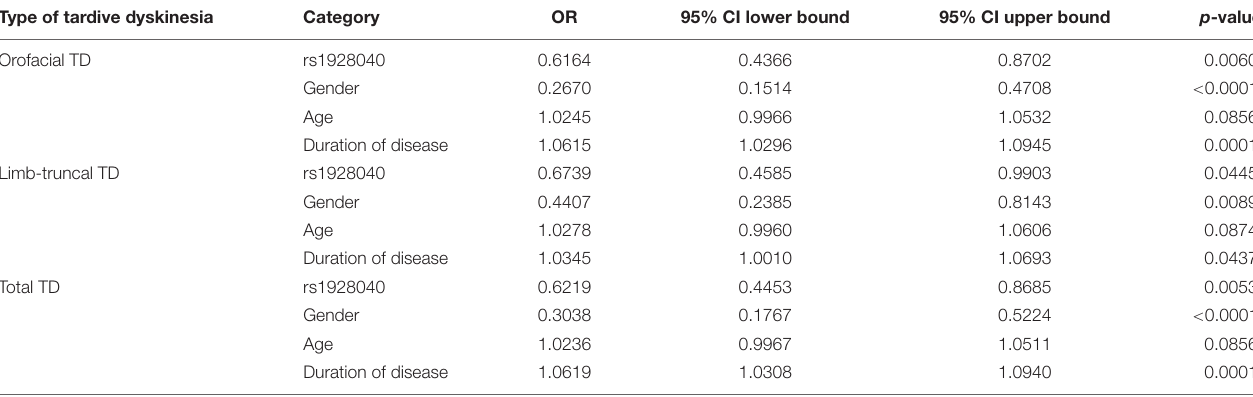
TABLE 4 | Variables related with different types of tardive dyskinesia analyzed by binary logistic regression. Type of tardive dyskinesia Category OR Orofacial